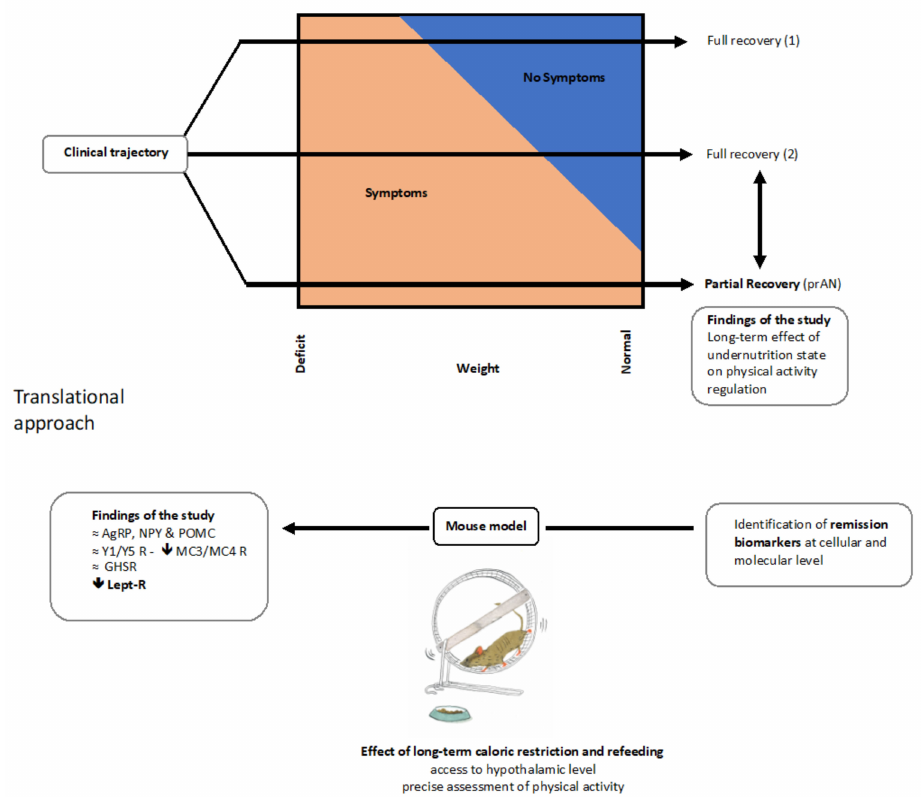
Figure 7. A translational approach of recovery in AN. Weight restoration is an important step of clinical management of patients suffering from AN. However, there is a high degree of inter-individual variability in the response to weight loss correction. Thus, some patients recover from their symptoms as soon as they start weight restoration (1) and others require significant weight gain to see their symptoms improving (2). Others still have symptoms despite full weight recovery: it is partial recovery (prAN). Our initial data on patients with prAN describe a long-term effect of undernutrition state on physical activity regulation. Beyond the recovery of a normal weight, it is necessary to describe objective biomarkers of remission. To identify them at the cellular or molecular levels, mouse models mimicking the effect of prolonged weight deficit on brain tissues after weight recovery is proving very useful. We demonstrated here the persistence of alteration of the central leptinergic pathway ten days after weight recovery. AgRP: agouti related-peptide; NPY: neuropeptide Y; POMC: pro-opiomelanocortin; Y1-R/Y5-R: neuropeptide Y receptor 1/receptor 5; MC3R/MC4-R: melanocortin 3 and 4 receptors; GHSR: ghrelin receptor; Lept-R: leptin